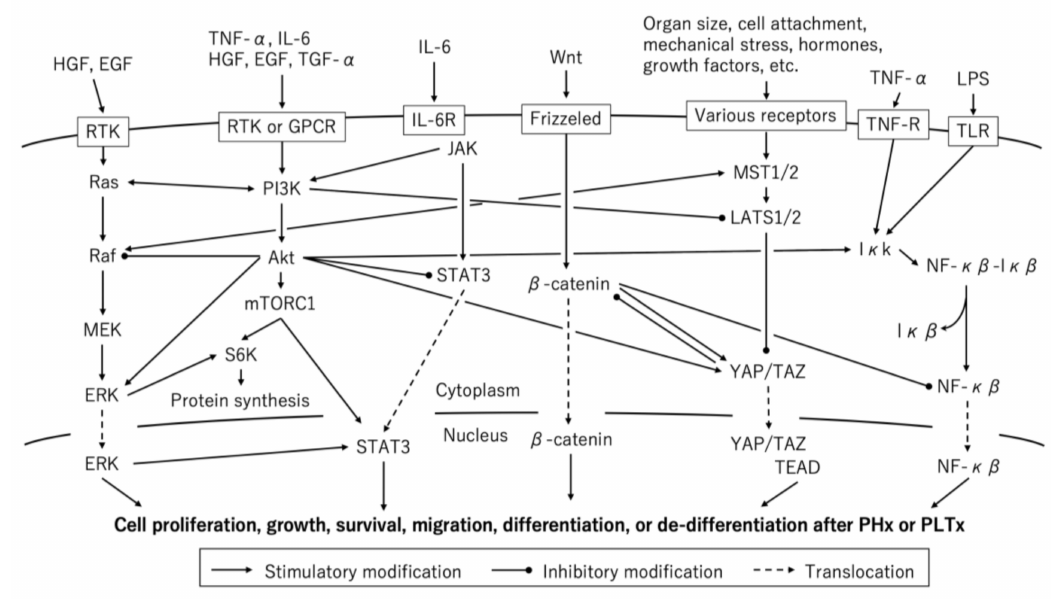
Figure 2. Molecular pathways associated with liver regeneration after partial hepatectomy (PHx) and partial liver transplantation (PLTx). EGF, epidermal growth factor; GPCR, G-protein-coupled receptor; HGF, hepatocyte growth factor; IFN, interferon; IL, interleukin; LPS, lipopolysaccharide; mTORC1, mammalian / mechanistic target of rapamycin complex 1; RTK, receptor tyrosine kinase; TGF, transforming growth factor; TLR Toll-like receptor; TNF, tumor necrosis